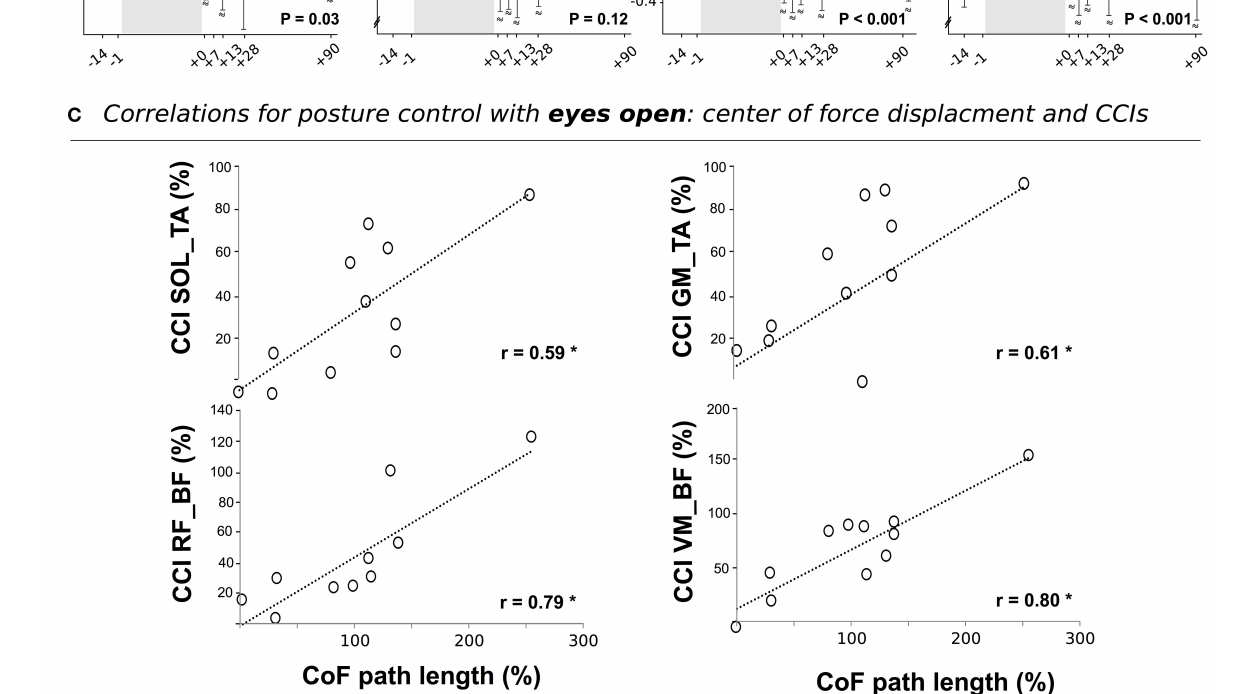
Frontiers in Physiology | www.frontiersin.org